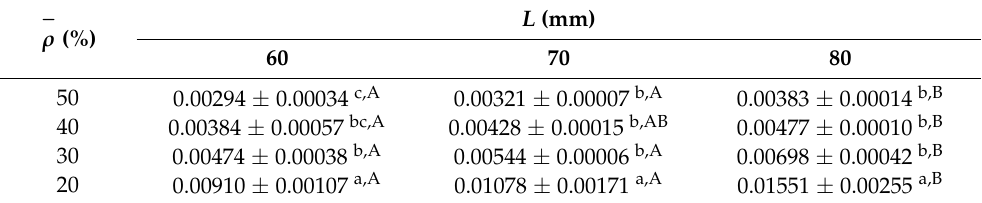
Table 2. δ /L data for the star structure.